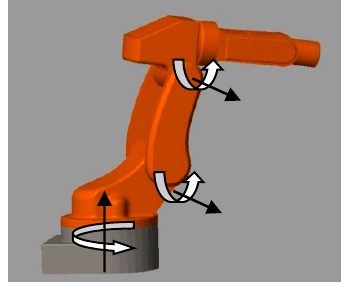
Figure 3. A 3-degree-of-freedom (DOF) robot manipulator in Matlab / Table 1. Parameters of 3-DOF robot manipulator in Matlab simulation.